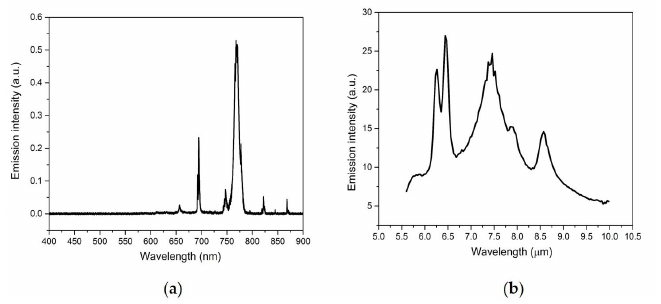
Figure 6. Simultaneous UV/Vis/NIR ( a ) + LWIR ( b ) LIBS spectrum of a solid KCl tablet.